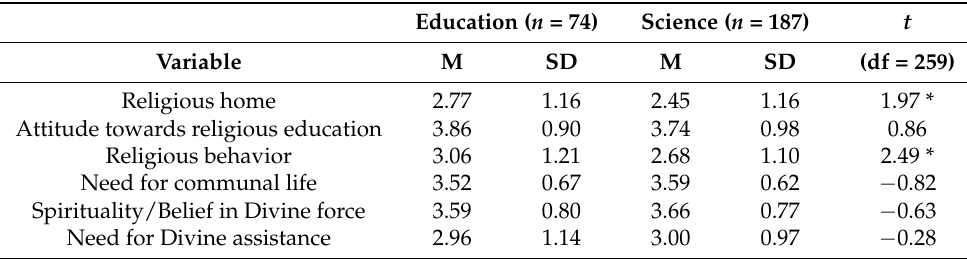
Table 4. Means, standard deviations, and the significance of differences in attitudes towards religion and spirituality between Jewish female students of education and